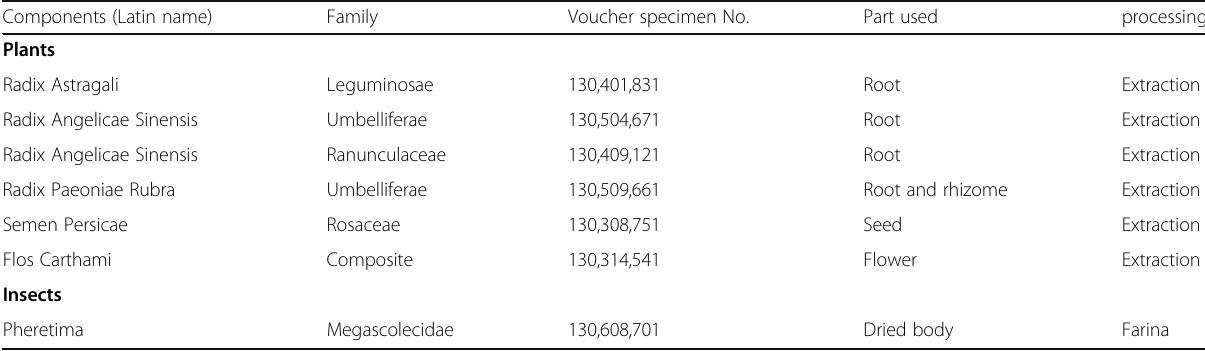
Table 1 Ingredients of